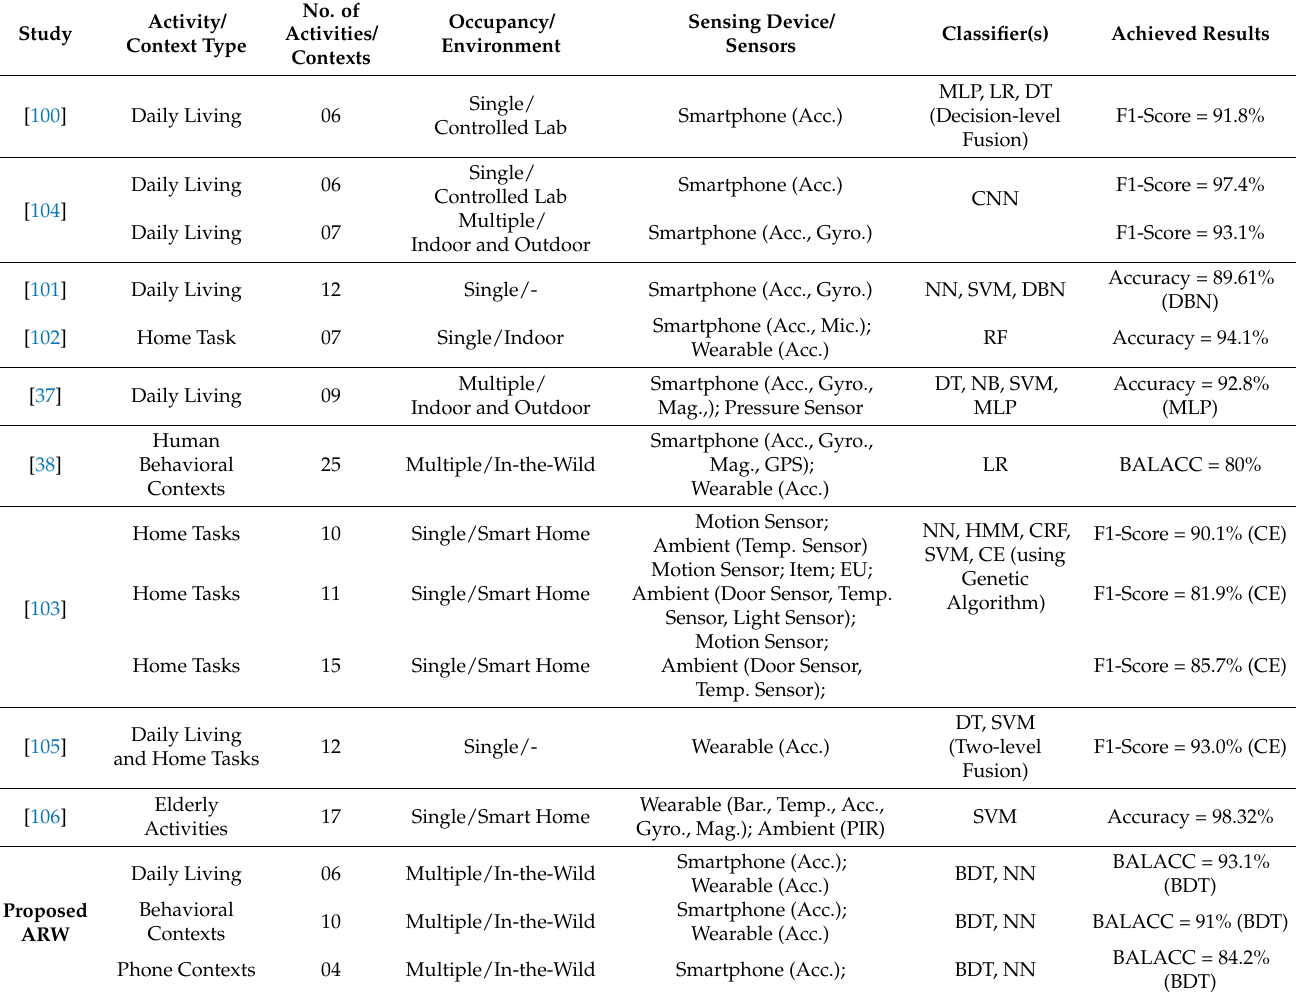
Table 9. Comparison of the proposed ARW scheme with previous